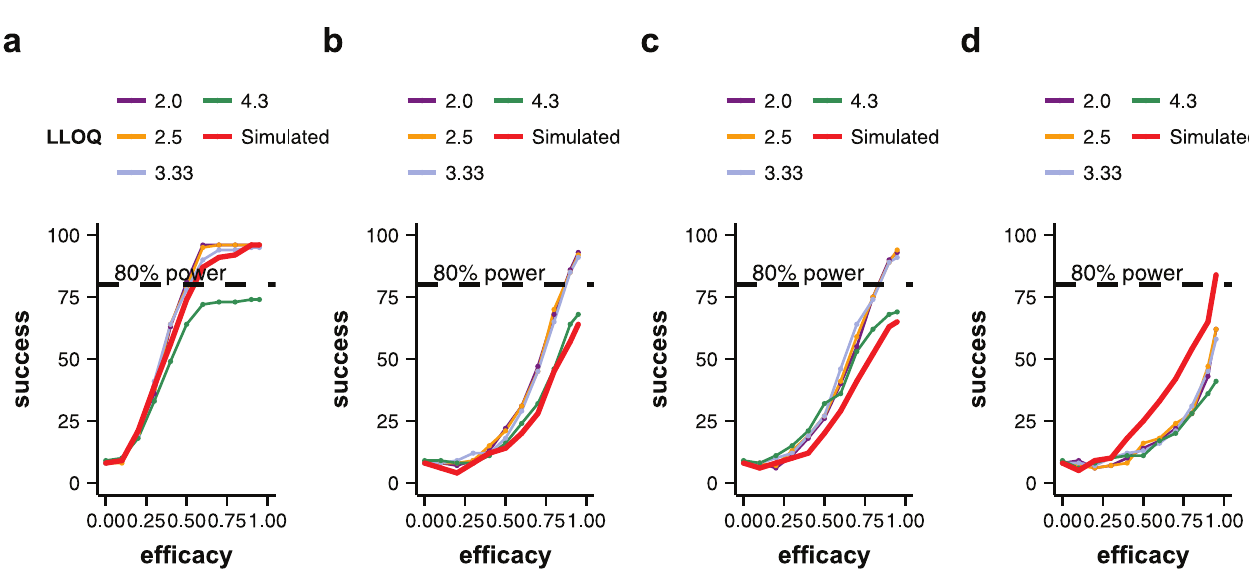
Fig 4. Experiment 5: Sensitivity of viral load assay (qPCR). Plots show the number of successful trials out of 100 runs (y-axis) over the assumed mean efficacy of treatment (x-axis). The probability of success corresponds to the power of the trial. The parameters determining the course of natural infection were drawn from the same random number distributions for each patient as explained in the main text. The efficacy for each patient (response) was fixed to the same value for each patient in each run. Thin coloured lines show the power of the trial dependent on the efficacy of the treatment for qPCR viral load assays assuming different lower limits of quantification. The bold red line shows the power of the trial dependent on the efficacy of the treatment, if the simulated viral load curve is considered. Very insensitive assays can greatly reduce the power of a trial, especially in potent drugs that act on several stages of the virus life cycle (a). Conversely, if the treatment acts on the infection rate (b) or the virus production rate (c), very sensitive viral load assays tend to give false positive results. Trials with 100 patients. a: treatment acts on all model parameters. b: treatment acts on the infection rate. c: treatment acts on the virus production rate. d: treatment acts on the virus clearance rate.